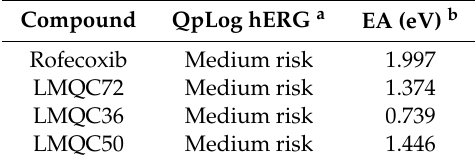
Table 9. Predictions of the cardiotoxicity properties of the selected